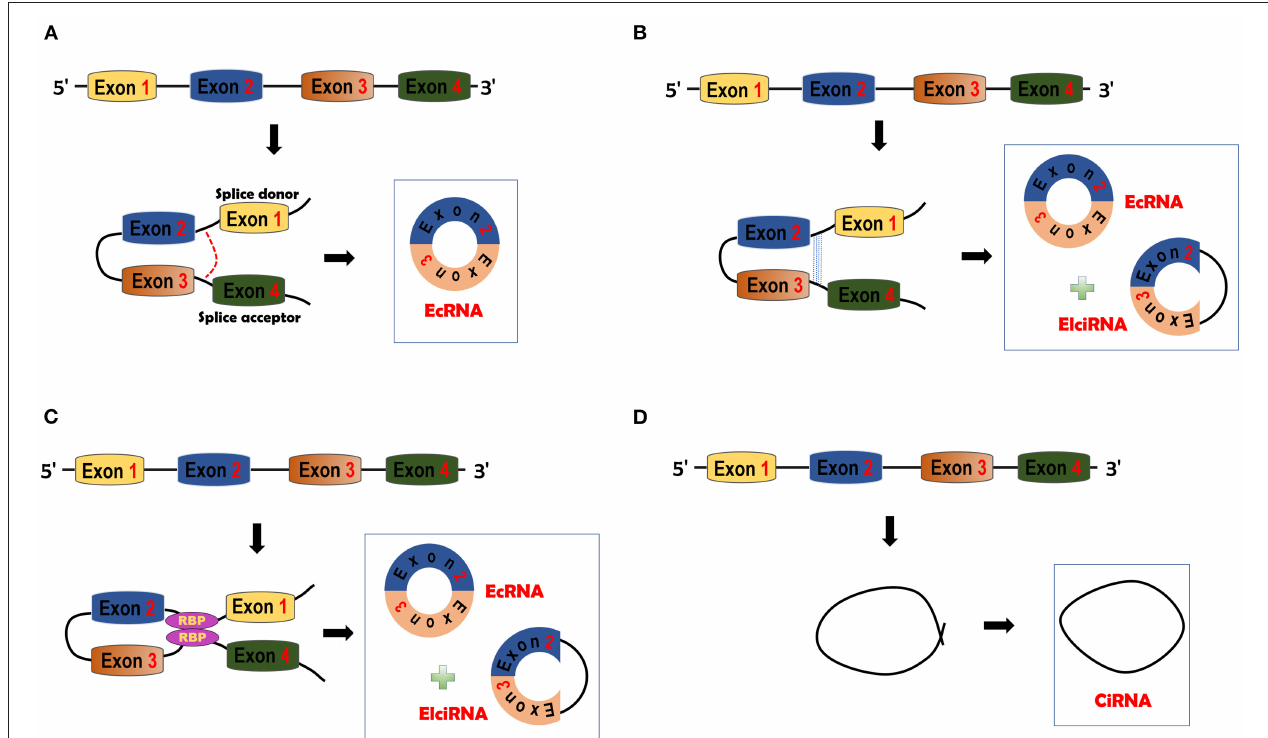
FIGURE 1 | circRNA biogenesis. (A) Lariat-driven circularization model. The splice donor and acceptor can be bound to form exon-containing lariats. Further splicing will generate exonic circRNAs (ecRNAs). (B) Intron pairing-driven circularization model. This model is facilitated by the complementary pairing of RNA base motifs (e.g., Alu repeats) in introns. EcRNAs or Exon-intron circRNAs (EIciRNAs) can be formed by this model. (C) RNA binding protein (RBP)-driven model. RBPs can bind with each other and serve as a bridge of pre-mRNAs. Bridging can facilitate the formation of ecRNAs or EIciRNAs. (D) Circular intronic RNA (ciRNA) is formed by Fwith other sequences eliminated by